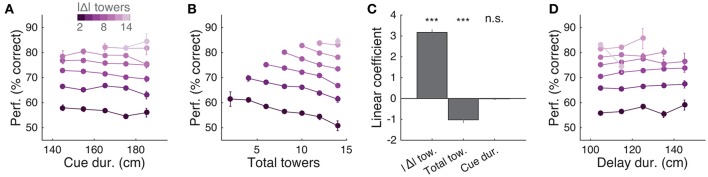
Behavioral performance decreases with increasing total number of towers, but not duration of cue period. (A) Overall performance as a function of effective cue period duration in space, for various subsets of trials with different absolute differences between tower counts (|Δ|, color code). Effective duration is defined as the position of the last viewed tower minus the position of the first tower. Error bars: binomial confidence intervals. (B) Overall performance as a function of the total number of towers (#R + #L), for subsets of trials with different |Δ|. Conventions as in (A). (C) Best-fit coefficients from a linear regression model predicting performance as a weighted combination of |Δ| towers, total towers, and effective cue period duration. The data is the mean-subtracted performance averaged across mice. Error bars: standard error for each parameter. Significance was calculated from parameter t-statistics. (D) Overall performance as a function of effective delay period duration in space for subsets of trials with different |Δ|. Error bars: binomial confidence intervals. Conventions as in (A). ***P < 0.001.